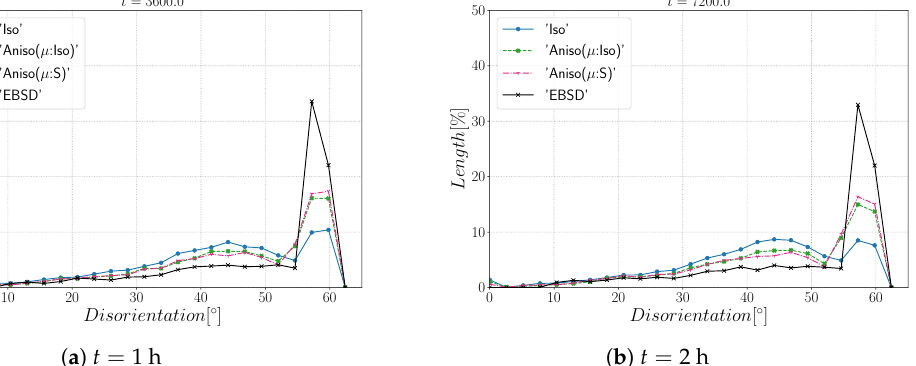
Figure 24. Disorientation distribution obtained at ( a ) t = 1 h and ( b ) t = 2 h for the isotropic (Iso) formulation, anisotropic formulations with isotropic GB mobility (Aniso( µ :Iso)) and heterogeneous GB mobility (Aniso( µ :S)), and the experimental data (EBSD). The Y-axis represents the GB length percentage. Numerical results obtained from the initial immersed microstructure shown in Figure 18 and the RS and sigmoidal model to define GB energy and